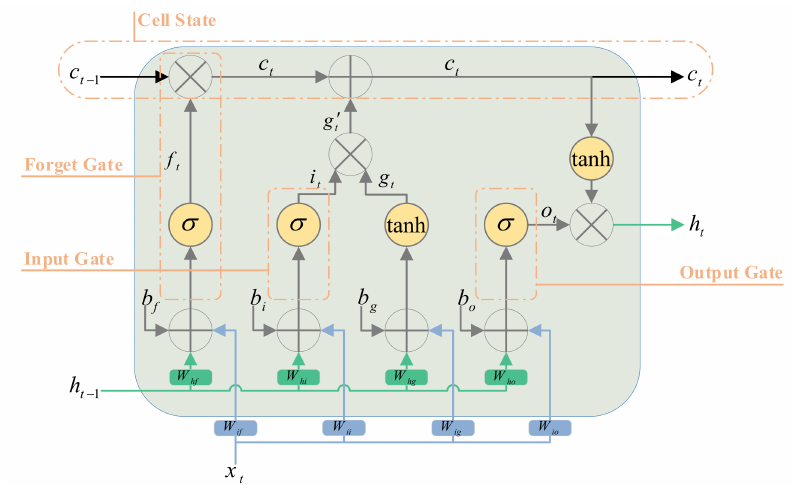
Figure 2. Illustration of LSTM